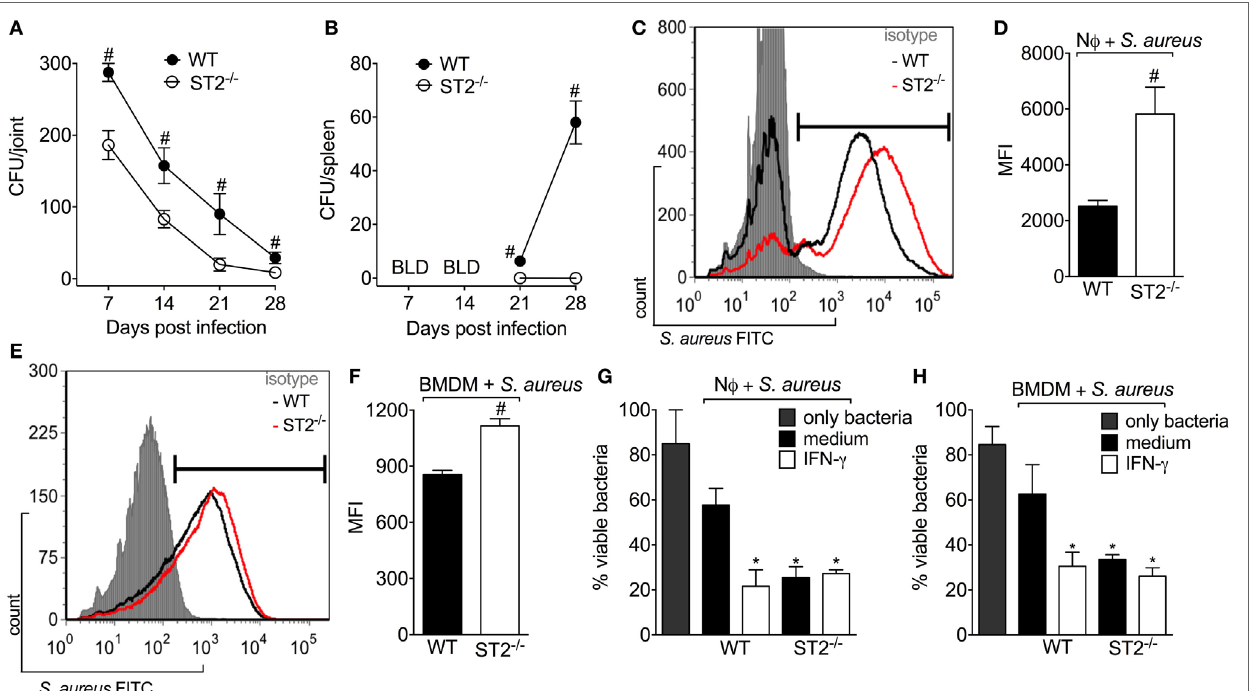
FigUre 3 | ST2 deficiency enhances neutrophil and macrophages bactericidal activity against Staphylococcus aureus. S. aureus was injected in the femur-tibial joint of wild-type (WT) and ST2 − / − mice. At indicated points (7–28 days post-infection), (a) knee joints and (B) spleen samples were collected and bacterial counts were determined on agar dishes. (c,D) FACS analysis of neutrophils (1 × 10 6 ) from WT and ST2 − / − naïve mice incubated in vitro with S. aureus at a multiplicity of infection (MOI) of 3 to evaluate phagocytosis. (e,F) FACS analysis of naïve bone marrow-derived macrophages (BMDMs) (1 × 10 6 ) from WT and ST2 − / − naïve mice incubated in vitro with S. aureus at a MOI of 3 to evaluate phagocytosis. Microbicidal activity of neutrophils (g) and BMDM (h) from WT and ST2 − / − naïve mice preincubated with interferon- γ (IFN- γ ) (100 IU/ml, 1 h) against S. aureus . All neutrophils were harvested from the bone marrow of mice. N = 6 wells per group per in vitro experiment, representative of two independent experiments. One-way ANOVA followed by Tukey’s test. # P < 0.05 vs WT mice group (a,B) . Samples were pooled from 10 mice per group per in vitro experiment, representative of two independent experiments. One-way ANOVA followed by Tukey’s test. # P < 0.05 vs WT neutrophils or BMDM group (c–F) . * P < 0.05 vs WT group preincubated with only medium (g,h)